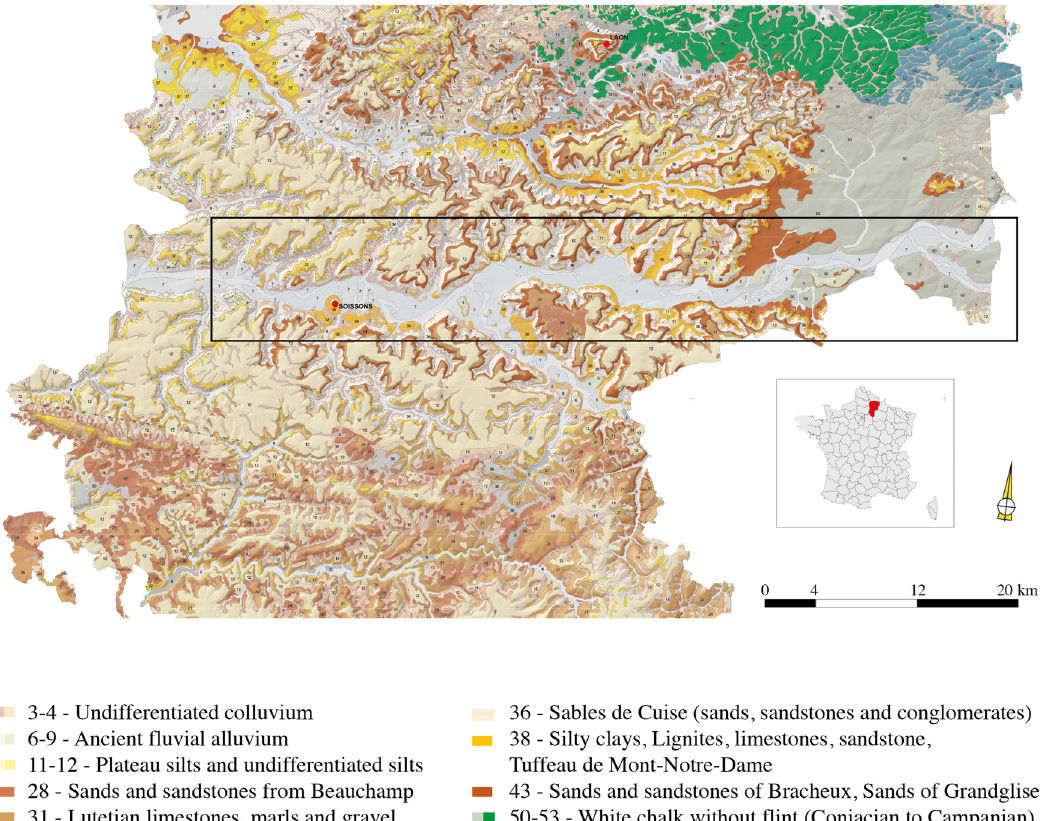
Figure 2: Geological map of the main formations of the Aisne Department ( according to Vernhet, 2008 ) . The studied area is indicated by the black